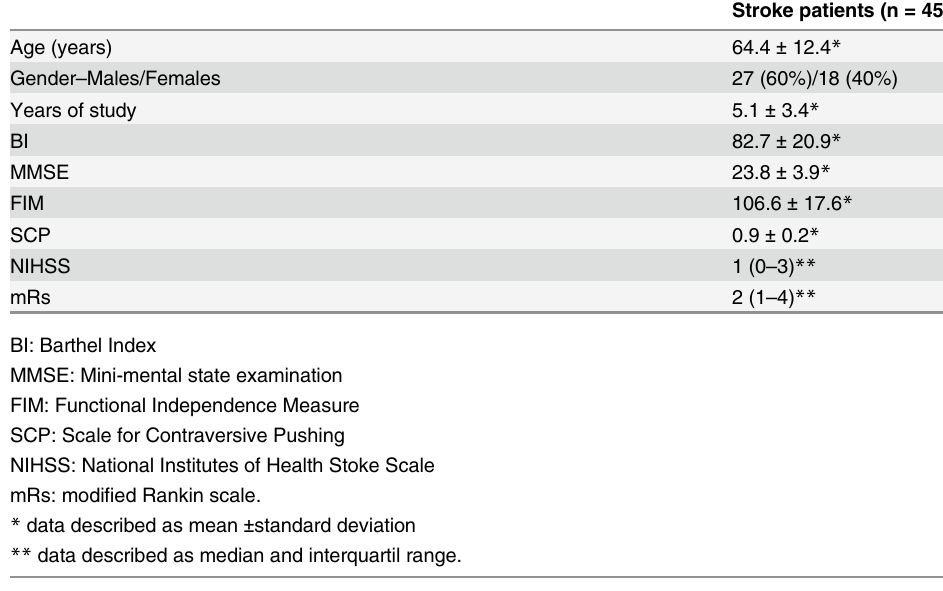
Table 1. Demographic and clinical characteristics of stroke patients.